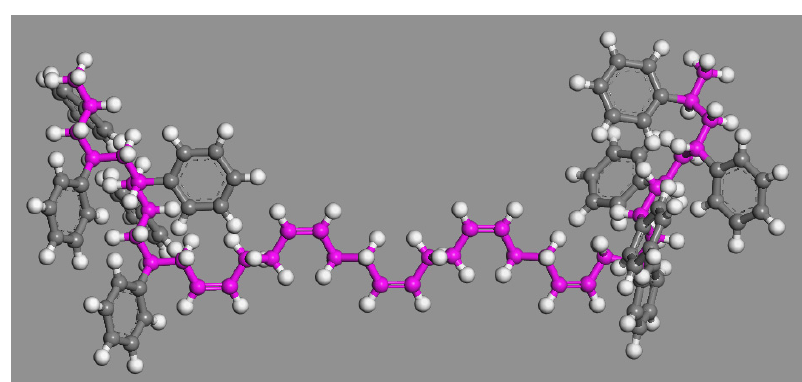
Figure 5. Molecular model of linear SBS.